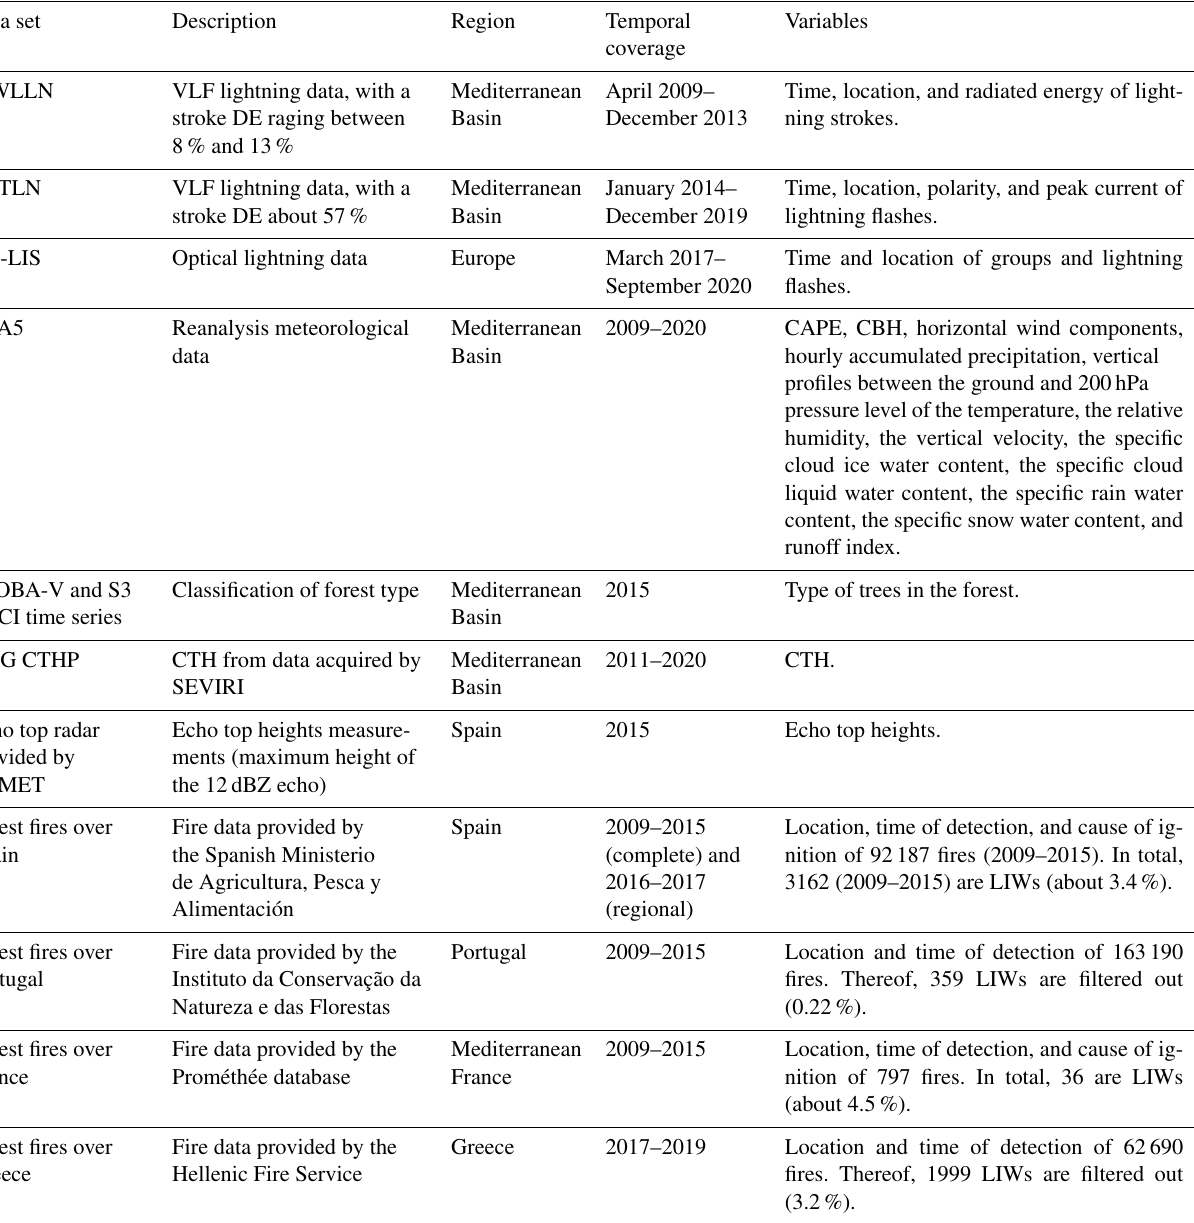
Table 1. Data sets used in this study. References are given in the text of Sect. 2. Note: DE – detection efficiency; VLF – very low frequency; CAPE – convective available potential energy; CBH – cloud base height; LIWs – lightning-ignited wildfires; CTH – cloud top